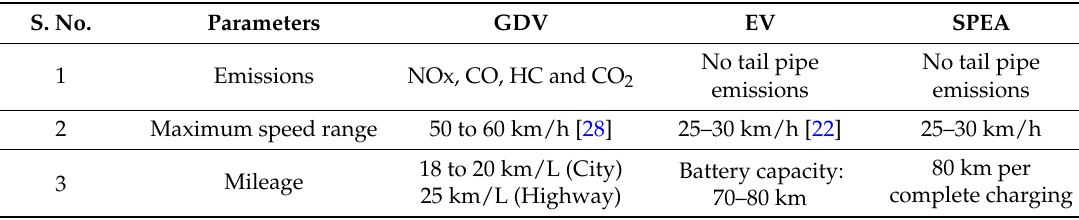
Table 5. Comparison of social consideration involved in vehicles.